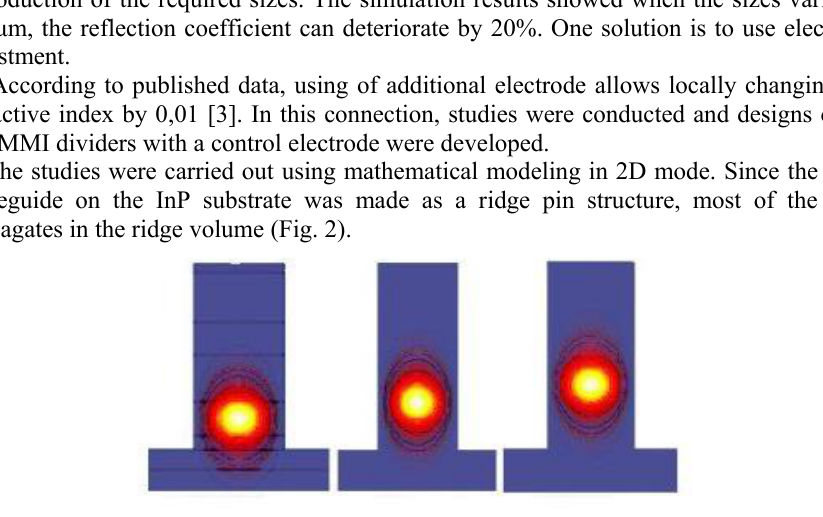
Fig. 2 . Layout view of light propagation in a ridge waveguide.